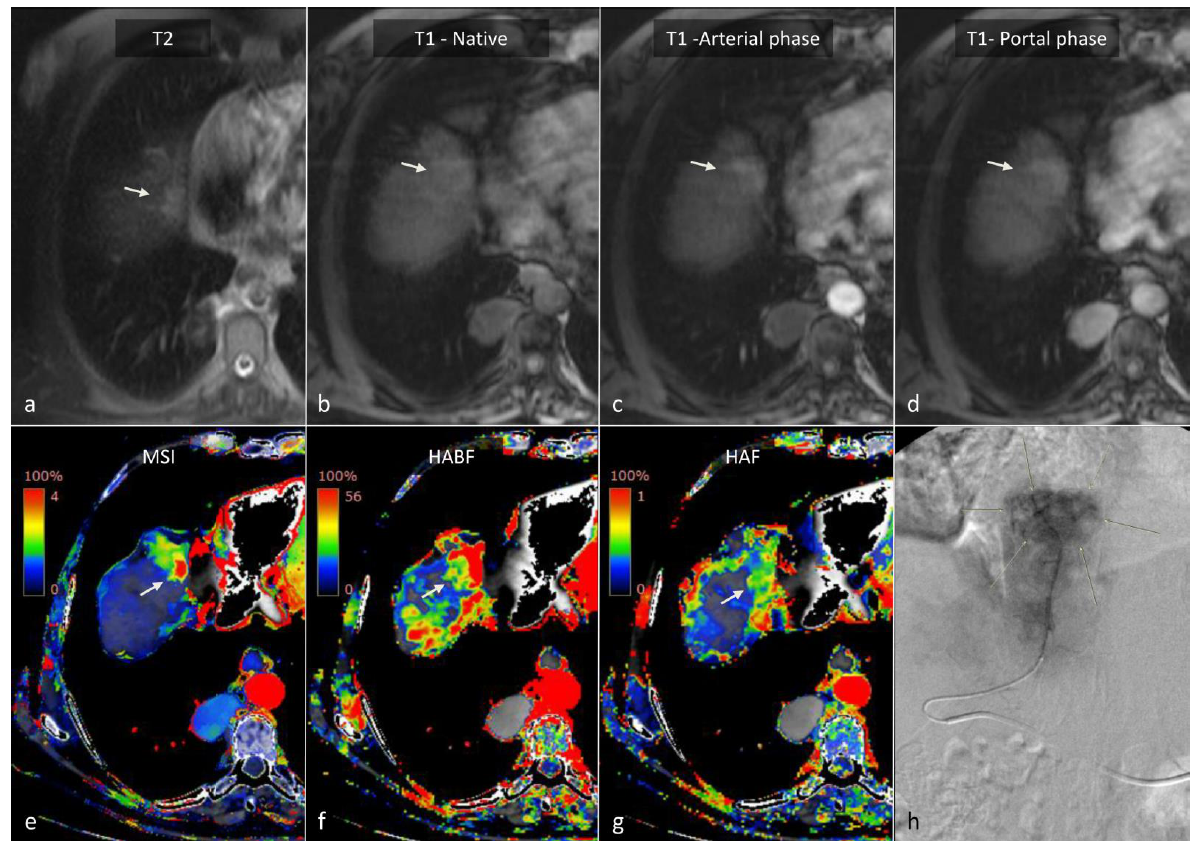
Figure 9. CT Liver Perfusion (CTLP) can complement other imaging modalities for establishing the diagnosis of HCC in difficult cases. This 70-year-old cirrhotic patient was previously treated for HCC with transarterial chemoembolization and presented with a 22-mm subdiaphragmatic lesion in liver segment 8 upon follow-up (arrows). The lesion had a high signal on T2 ( a ) and T1 ( b ) MRI. Contrast enhancement ( c ) and wash-out ( d ) could not be assessed on MRI due to the presence of artifacts. The MSI map of CTLP ( e ) clearly shows avid contrast enhancement in the HCC lesion, which was later confirmed with selective angiography ( h ). Although the Hepatic Arterial Blood Flow ( f ) and Hepatic Arterial Fraction ( g) parametric maps show high values in the HCC lesion, it cannot be differentiated from surrounding parenchyma due to cirrhosis and prior chemoemboli- zation, which alter normal liver hemodynamics. MSI; Mean Slope of Increase, HABF; Hepatic Arterial Blood Flow, HAF; Hepatic Arterial Fraction. Table 6. Glossary of commonly-reported CT and MRI perfusion parameters alongside expected changes in HCC lesions relative to surrounding liver parenchyma. Number of arrows indicates the magnitude of difference. Table 7. Differential diagnosis between HCC and other common liver lesions using CT Liver Perfusion and dynamic contrast-enhanced MRI parameters. Number of upwards or downwards pointing arrows indicate magnitude of change relative to surrounding liver parenchyma and HCC lesions in comparative